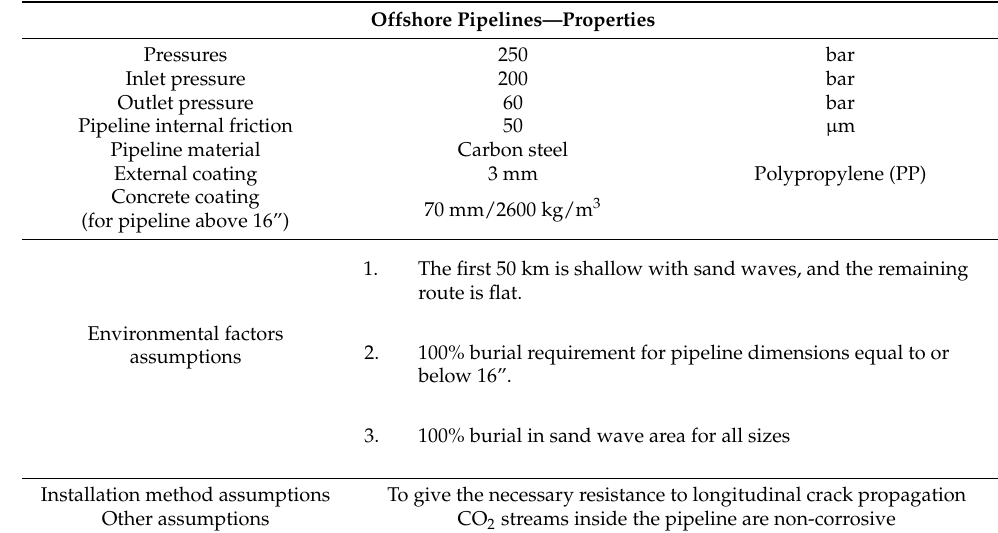
Table 10. Offshore pipeline properties, data is analyzed and summarized from